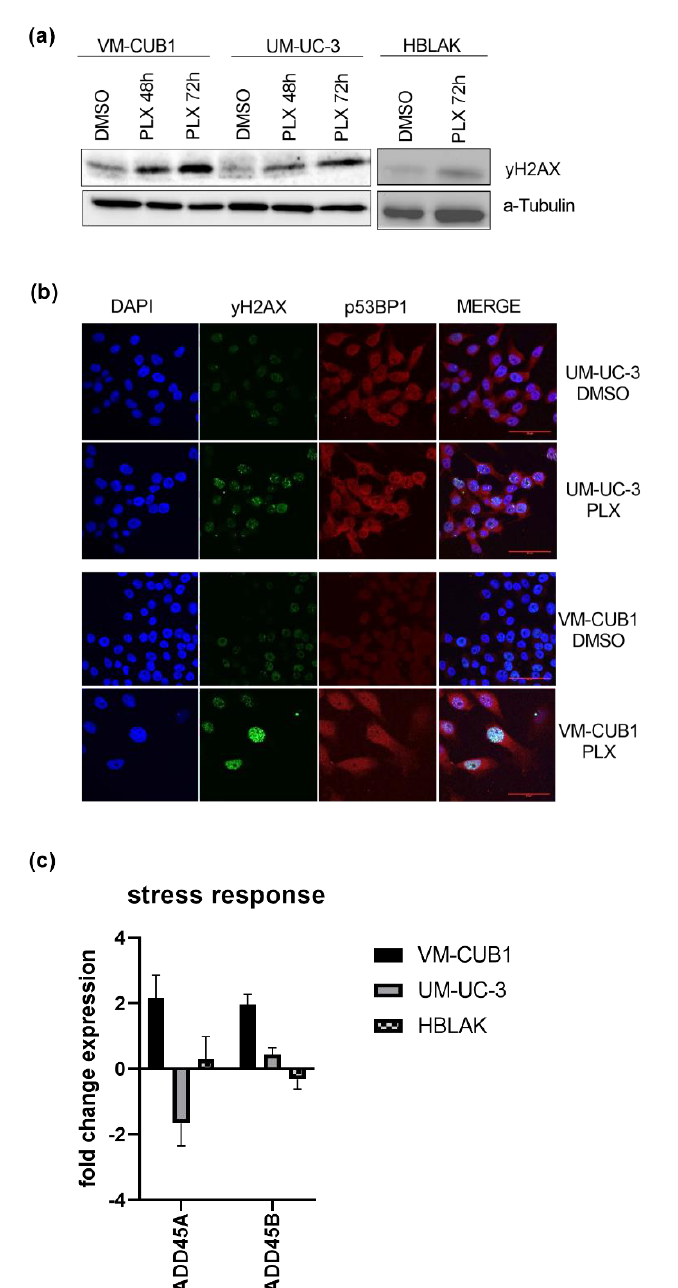
Figure 3. Induction of DNA damage by BETi treatment. ( a ) Increased phosphorylation of γ H2AX as a marker of DSB (double strand breaks) was determined by western blot analysis after treatment for 48 h and 72 h with cell line-dependent IC 50 doses of PLX. A-Tubulin served as a loading control. ( b ) Phosphorylated γ H2AX (green fluorescence) and p53BP1 (red fluorescence) were stained by immunocytochemistry and imaged by means of confocal microscopy (scale bar = 50 µ m). Background from secondary antibodies is shown in Figure S1d. ( c ) RNA expression 72 h after treatment with IC 50 doses of PLX was measured for the stress response markers GADD45A and GADD45B by qRT-PCR. RNA expression of indicated target genes was normalized to the reference gene TBP . Expression changes are displayed as fold change relative to the respective DMSO